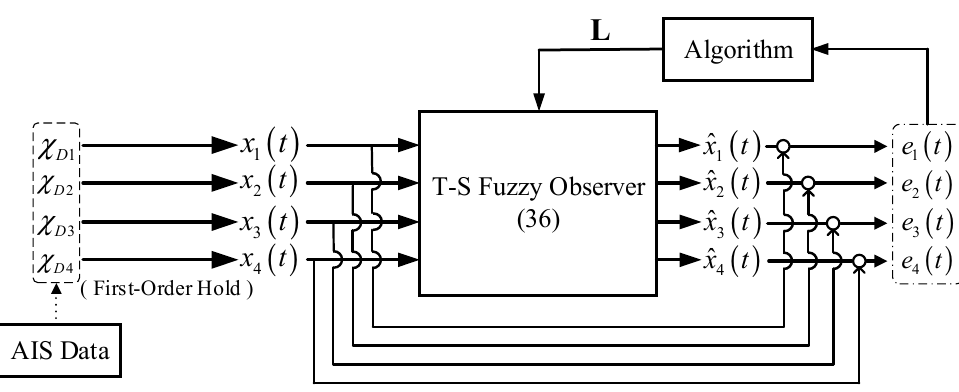
Figure 4. Estimating based on the proposed fuzzy observer